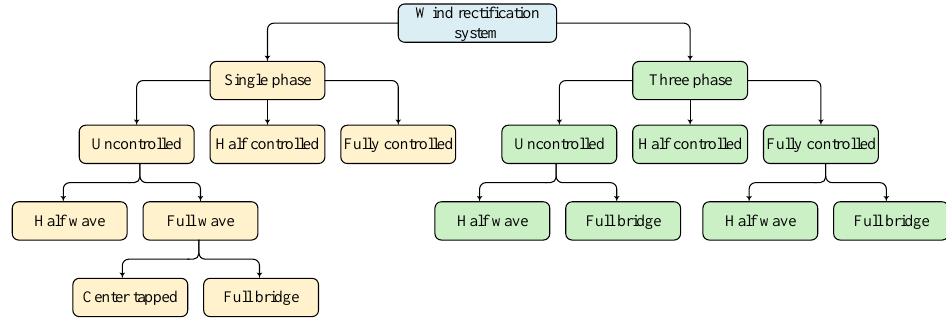
Figure 3. Classification of wind energy